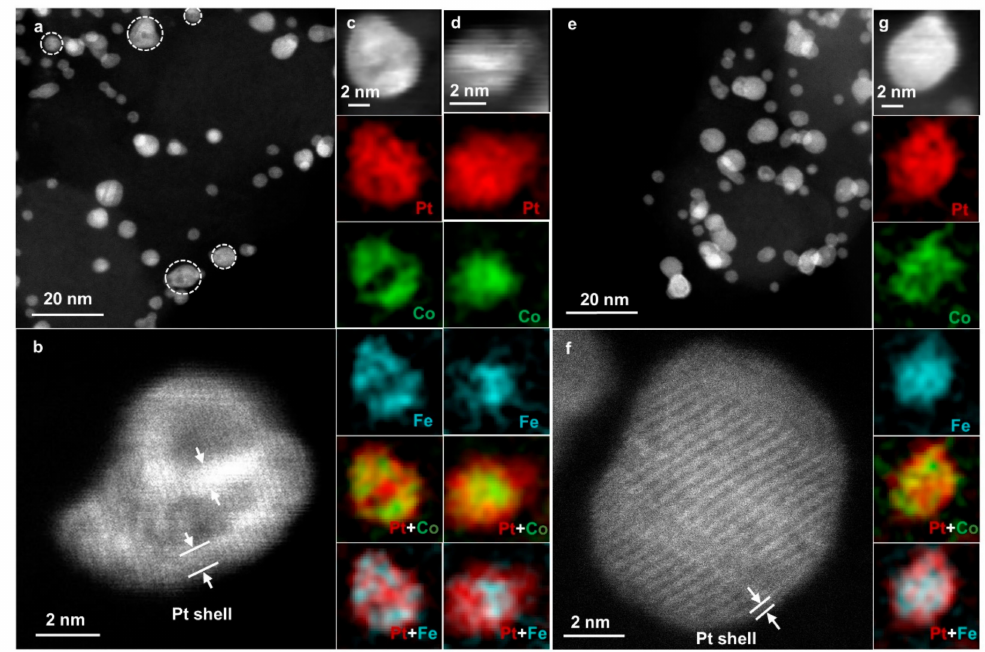
Figure 5. The STEM-EELS characterizations of disordered and ordered PtCoFe after dealloying. ( a , b , e , f ) STEM images of dealloyed PtCoFe-H400 and PtCoFe-H600 respectively; ( c , d , g ) EELS mapping of dealloyed PtCoFe-H400 and PtCoFe-H600,